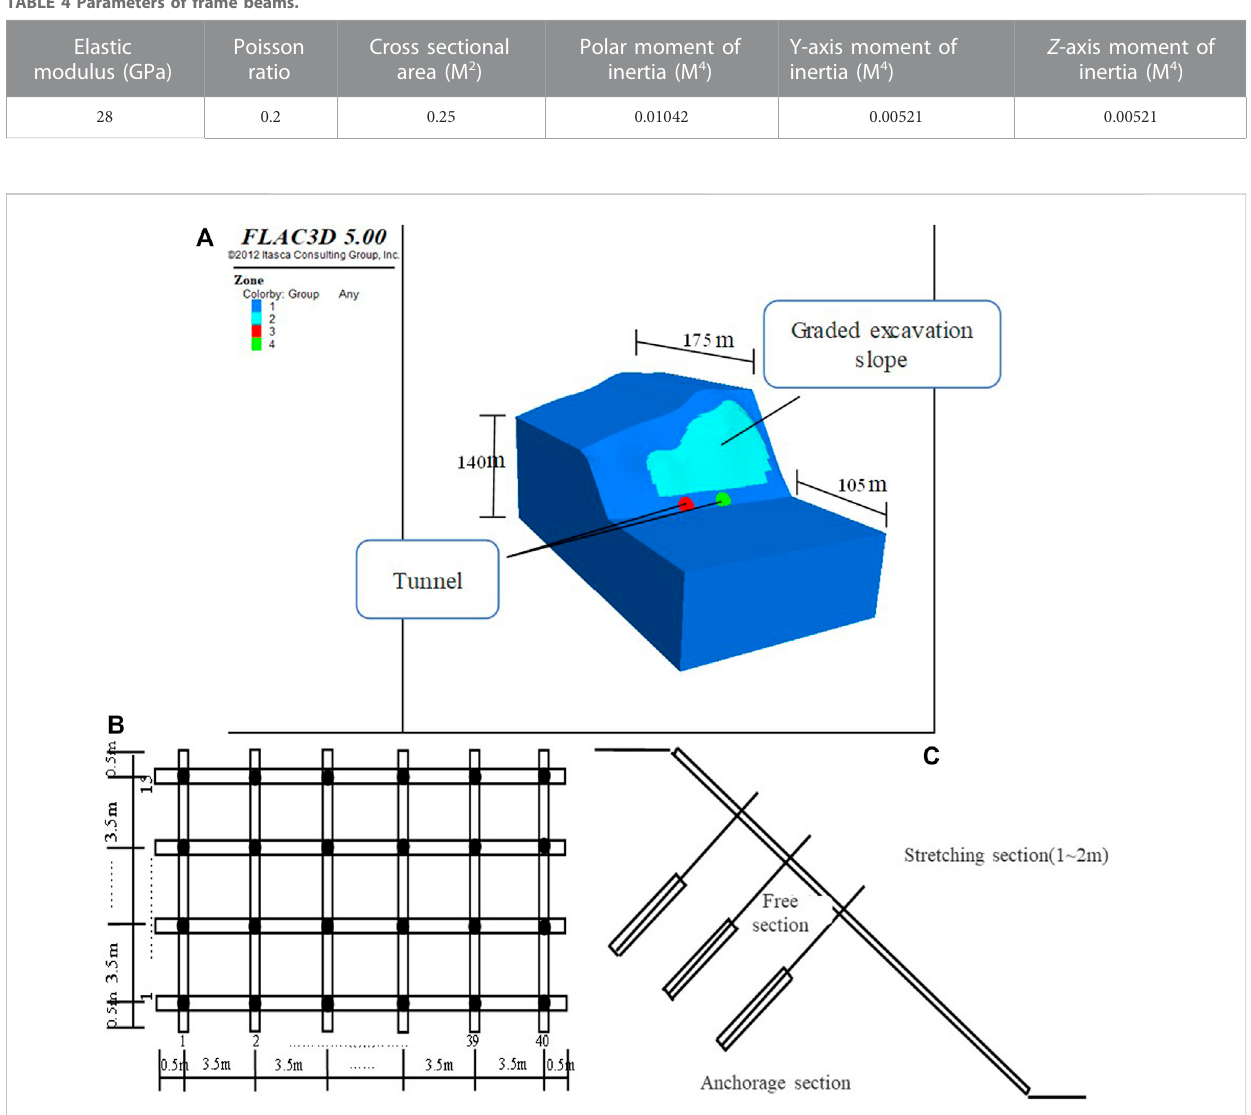
FIGURE 2 (A) Calculation of slope map; (B) Anchor cable and frame beam layout diagram; (C) Anchor cable